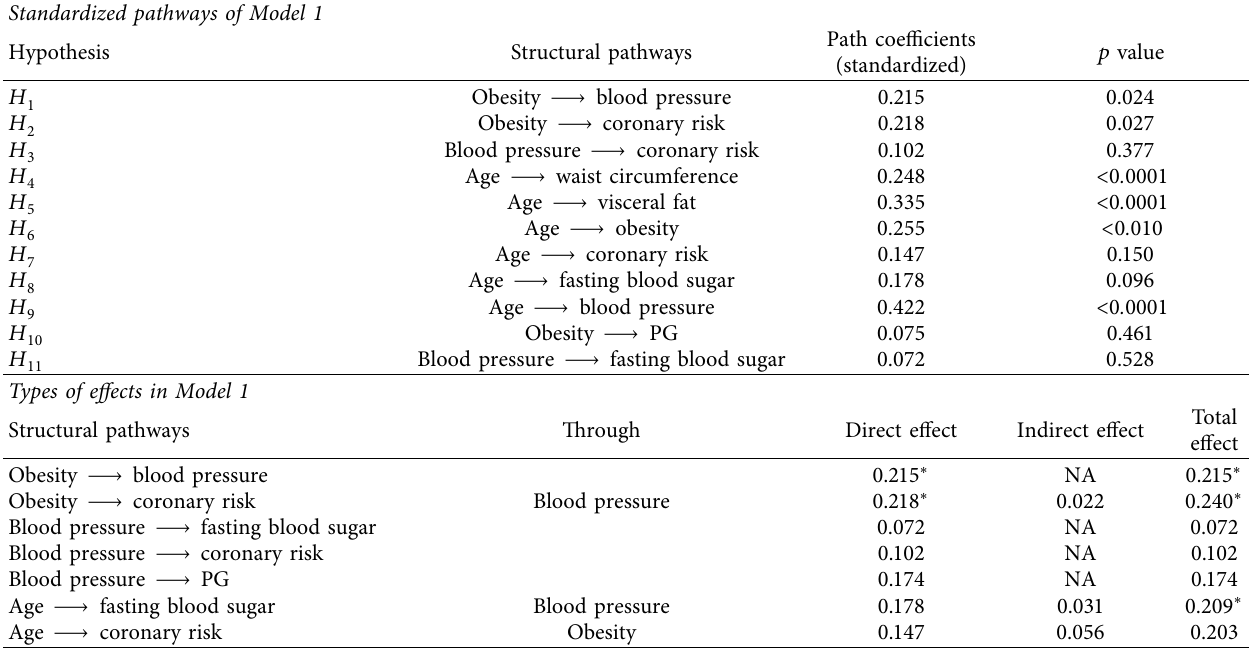
Table 4: Standardized pathways and type of effects of Model 1. Standardized pathways of Model